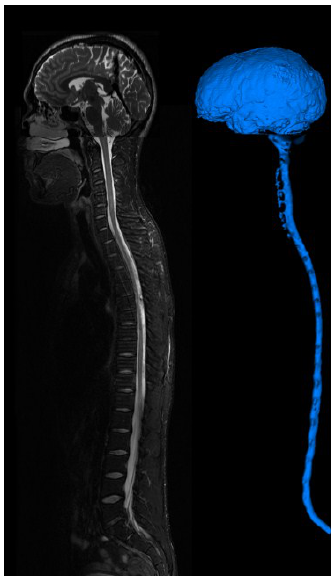
Figure 7. CSF imaging for the entire central nervous system. T2 images are acquired for the brain, cervical-thoracic region, thoracic-lumbar region, lumbar-sacral region. Image